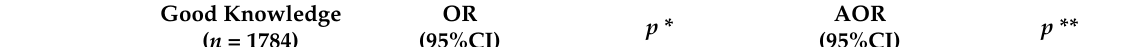
Table 6. Analysis of factors associated with knowledge about